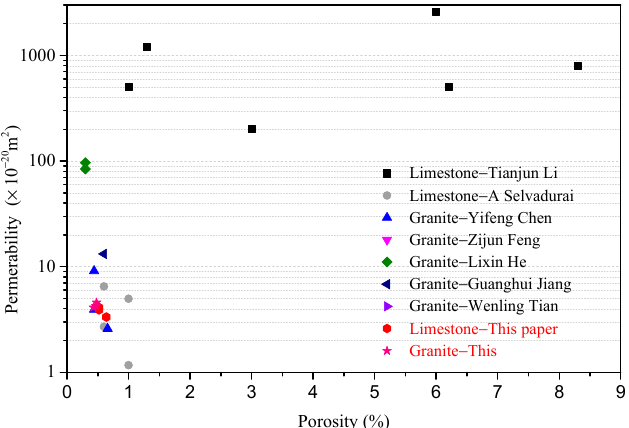
Figure 11. comparison of the experimental data with the results of other scholars on limestone and granite.